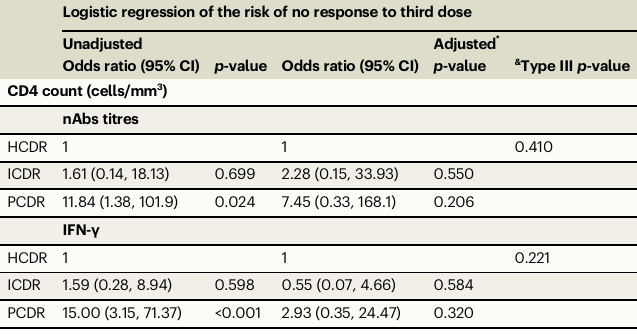
Table4 |CD4count-OR ofnon-responsefrom fi tting alogistic regression analysis Logistic regression ofthe riskof no responsetothird dose